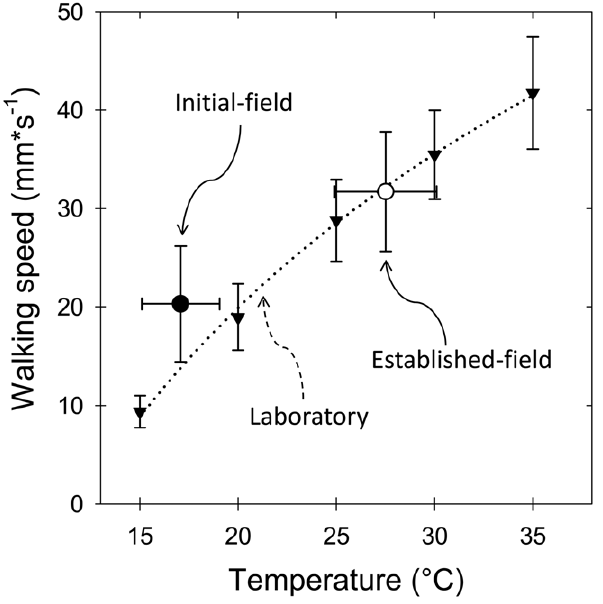
Figure 4. Average walking speed ( ± SD) of laden workers as a function of temperature, measured in the laboratory ( dotted line : walking speed= 2 95.56 + 88.75*(log 10 T), R 2 =0.89). The black and white circles represent the average walking speeds ( 6 SD) measured in the field at the indicated mean ( 6 SD) environmental temperatures, for both the initial and the established foraging phases.